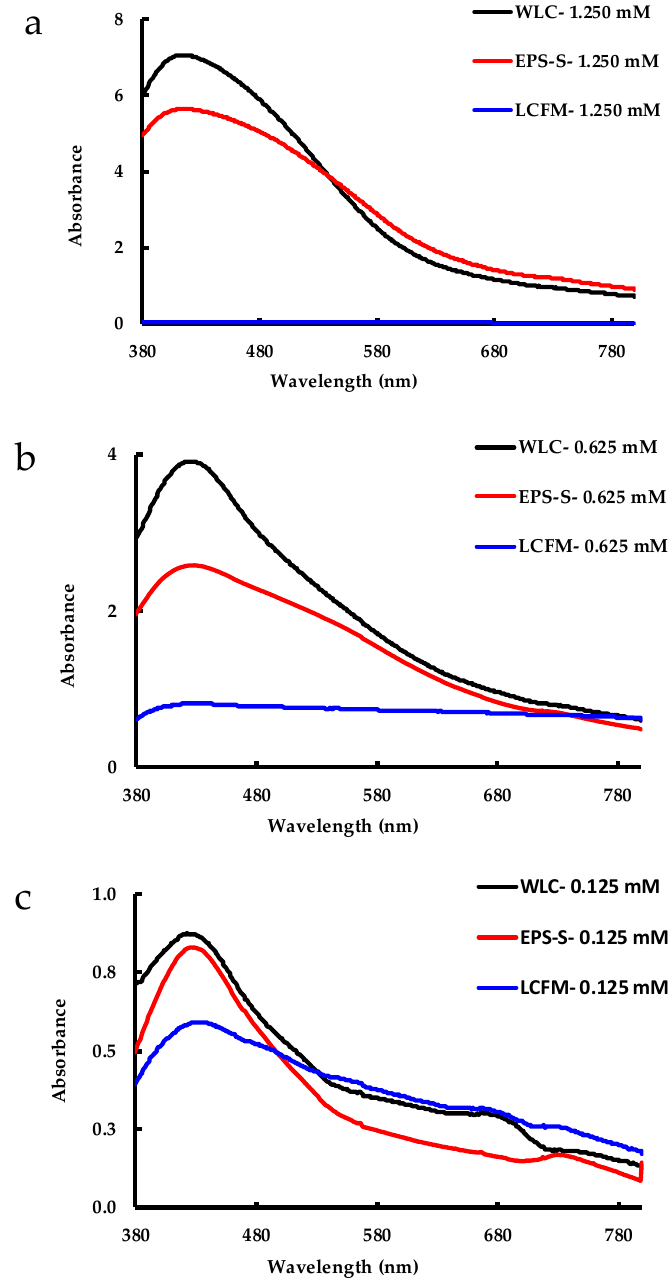
Figure 2. Spectrophotometric measurements for WLC, EPS-S and LCFM after 24 h of reaction at AgNO 3 concentrations of: ( a ) 1.250 mM; ( b ) 0.625 mM; and ( c ) 0.125